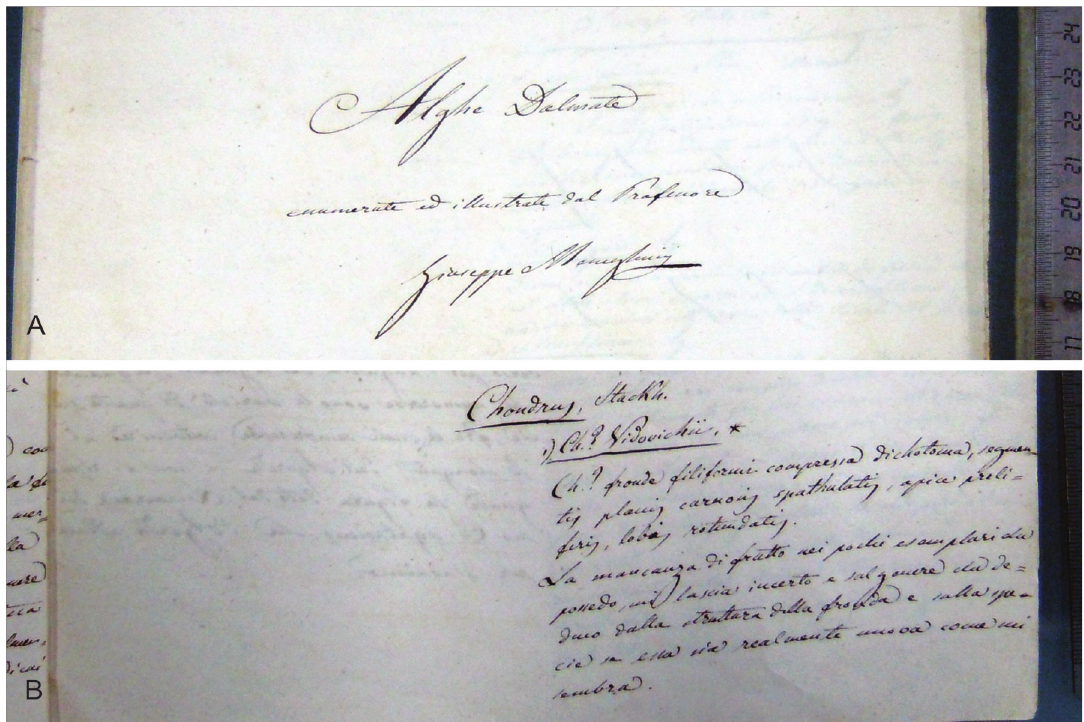
Fig. 5. A . Detail of front page of Meneghini’s 1841 manuscript “ Alghe Dalmate, Enumerate ed Illu- strate dal Professor Giuseppe Meneghini ”. B . Detail of protologue page of Chondrus? vidovichii (Menegh.) Zanardini.